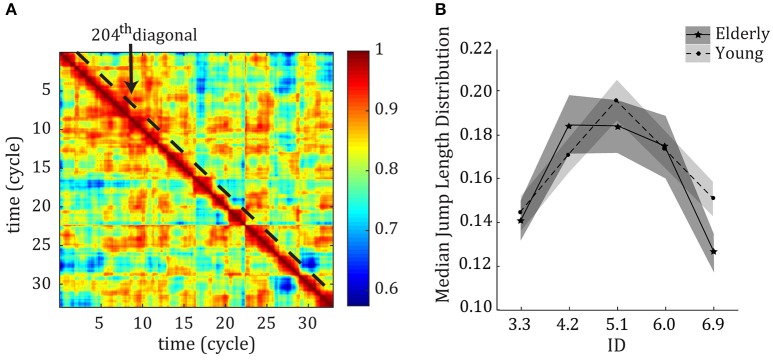
(A) Example of an FCD matrix, including the 204th diagonal over which the data was analyzed. (B) Median Jump length distribution (JLD) curve of the FCD per ID across young (dotted line) and older (solid line) participants P < 0.05. Error bars denote 1 standard deviation.